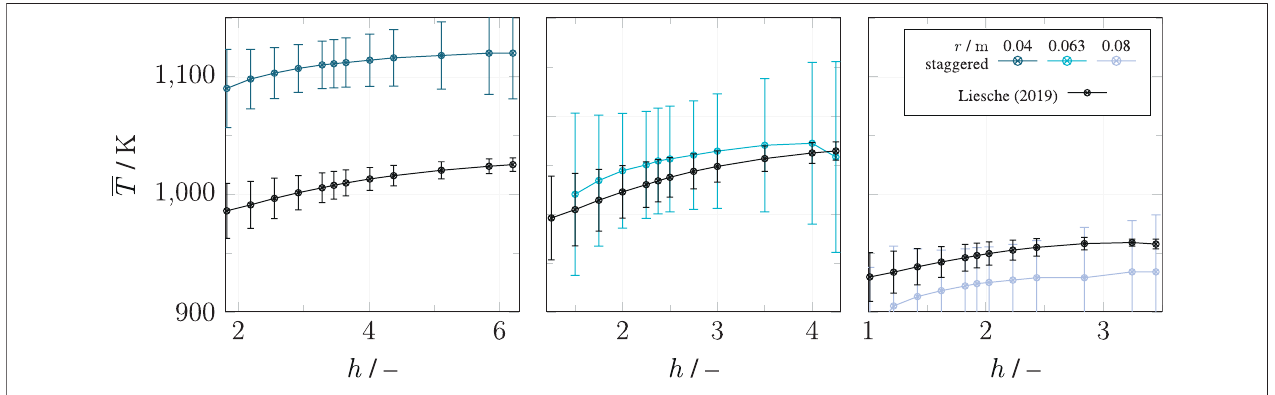
FIGURE11|(A) Meantubesurfacetemperature T vs.distancefactor h forstaggeredarrangements (B) basedontheradiationmodel(black)andCFDmodel(blue) for three different tube radii. Error bars show the standard deviation of the respective data